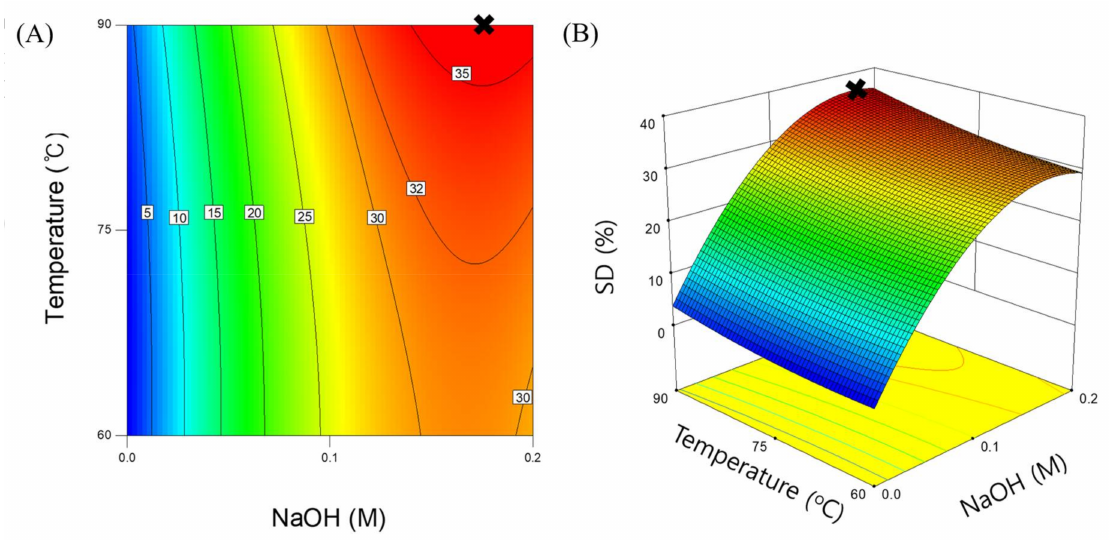
Figure 3. Two-dimensional ( A ) and three-dimensional ( B ) contour plots of the response surface for the degree of solubilization (SD). The cross mark indicates the point of the maximum SD response.